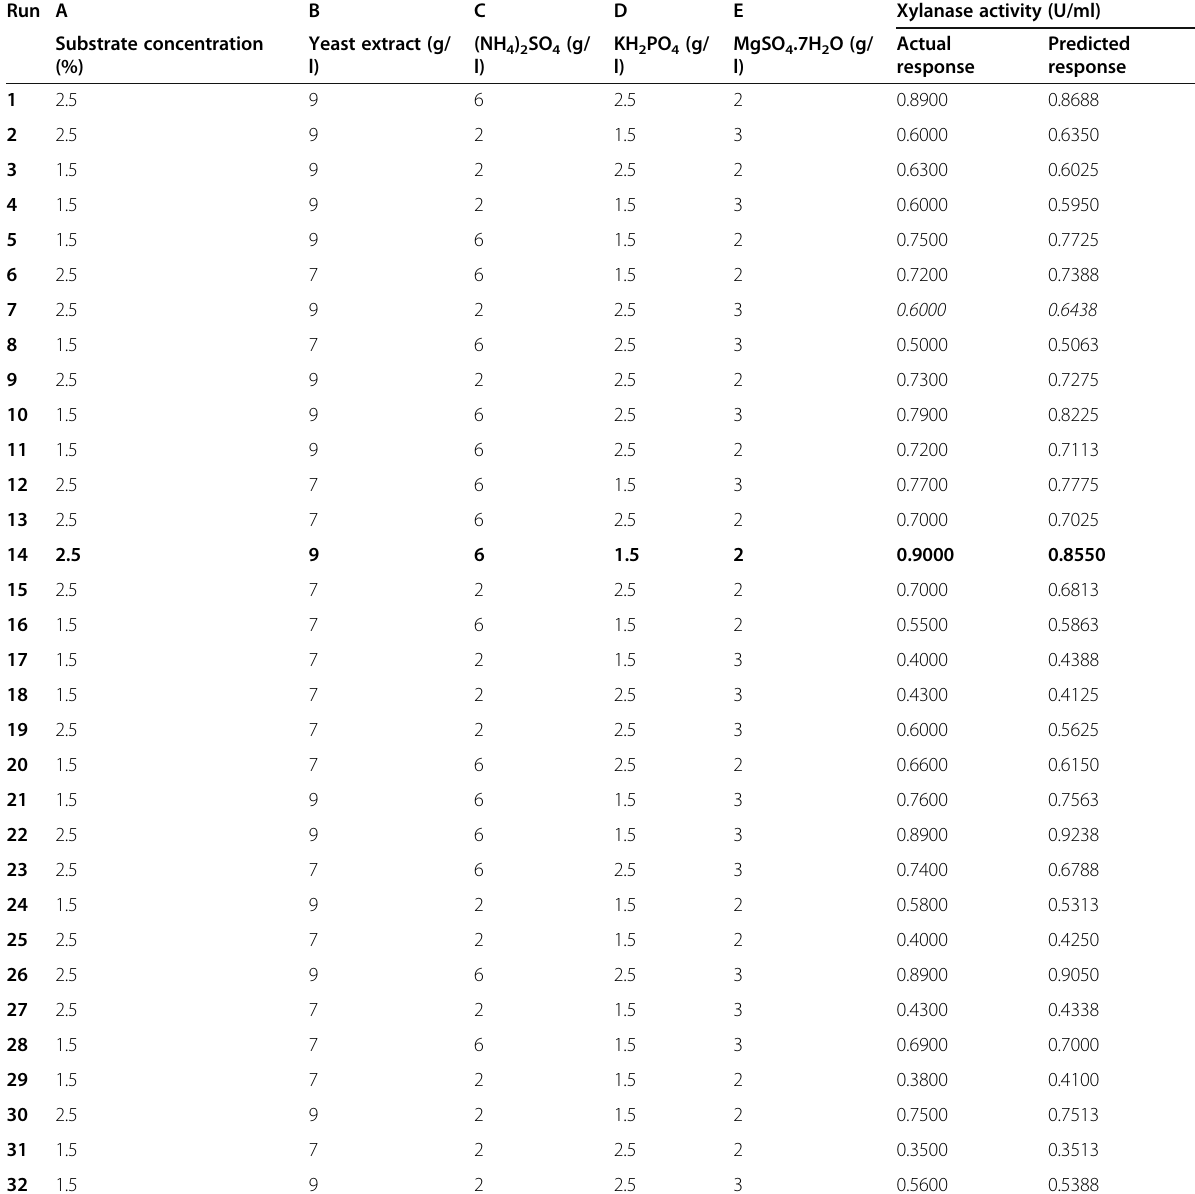
Table 2 Two-level factorial design of variables (in coded levels) with actual values and predicted response Run A B C Substrate concentration